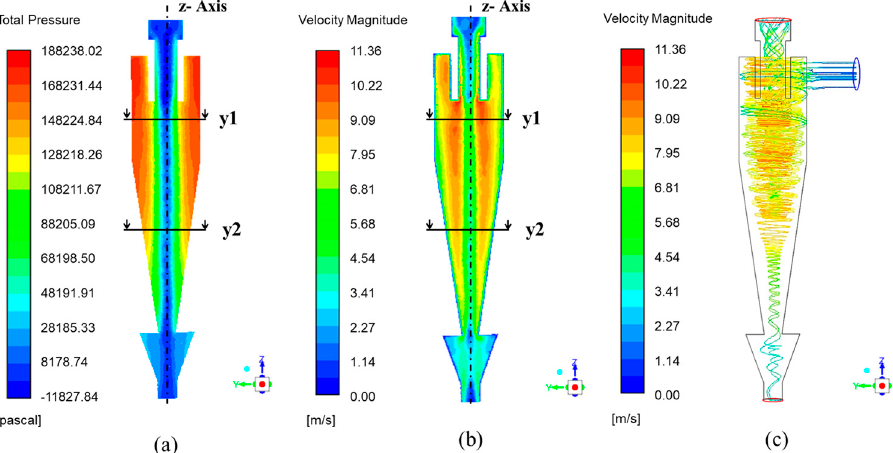
Figure 5. Contour of Model 1 injected with 5 percent particles; ( a ) Total pressure, ( b ) Velocity magnitude, and ( c ) Vortices distribution.